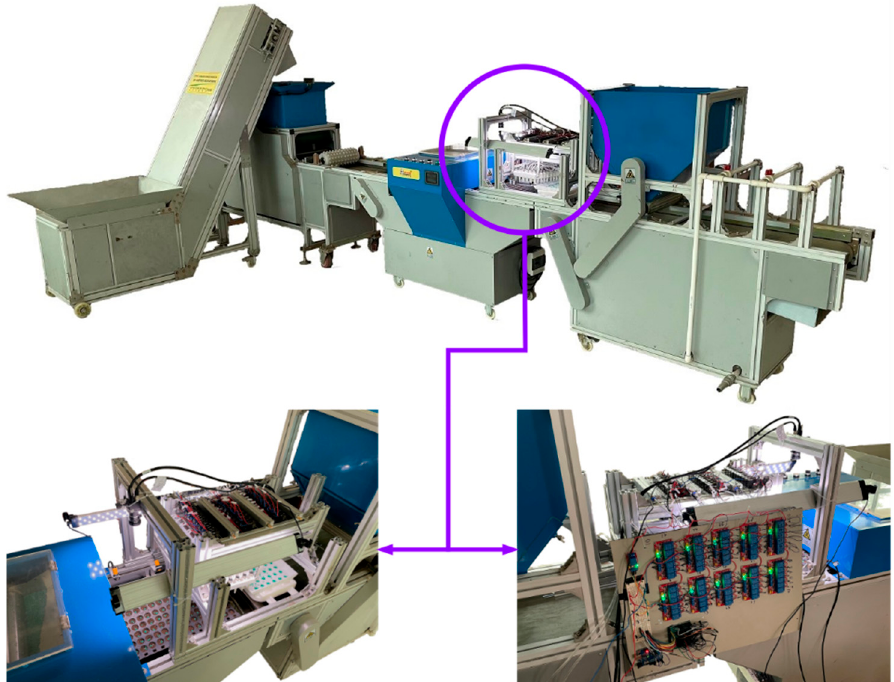
Figure 27. Proposed complementary seeding unit.